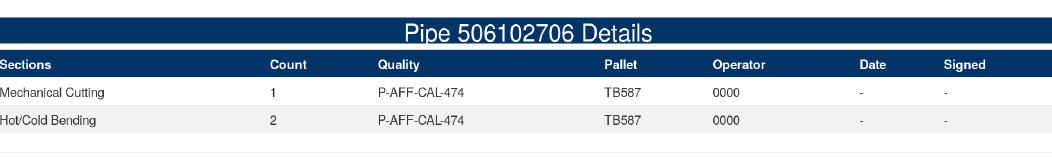
Figure 13. Details of a specific pipe.